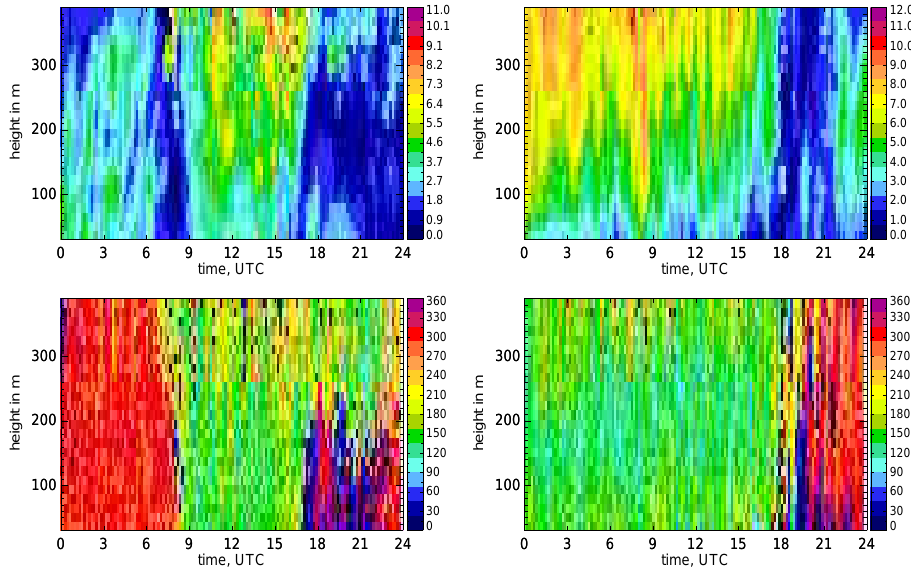
Fig. 11. Wind speed (top) and wind direction (bottom) at Jesenice on 21 September 2006 (left) and on 24 October 2006 (right). Figure11:Windspeed(top)andwinddire tion(bottom)atJeseni eon21September2006(left)andon24O tober